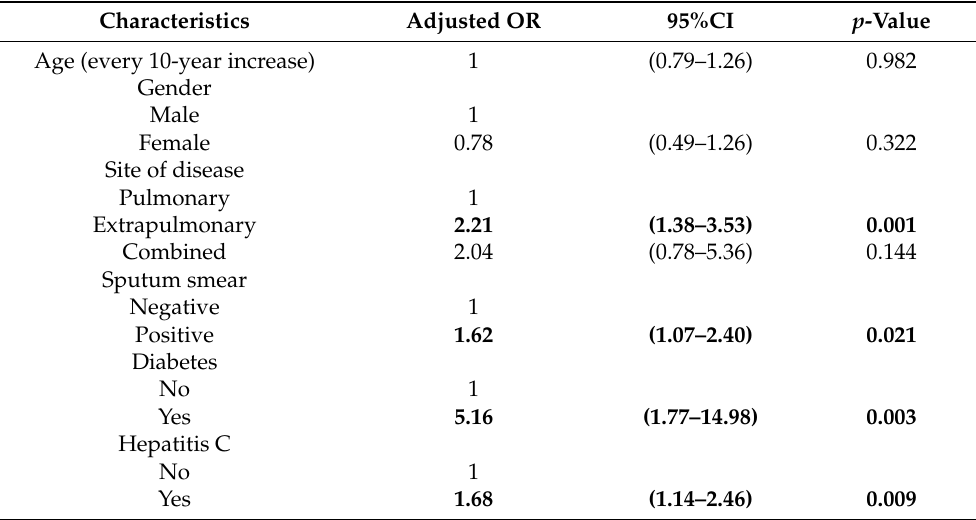
Table 3. Adjusted risk factors associated with unfavorable (failure, lost to follow up, death, not eval- uated) treatment outcomes among HIV-associated TB patients registered in Tashkent city, Uzbekistan